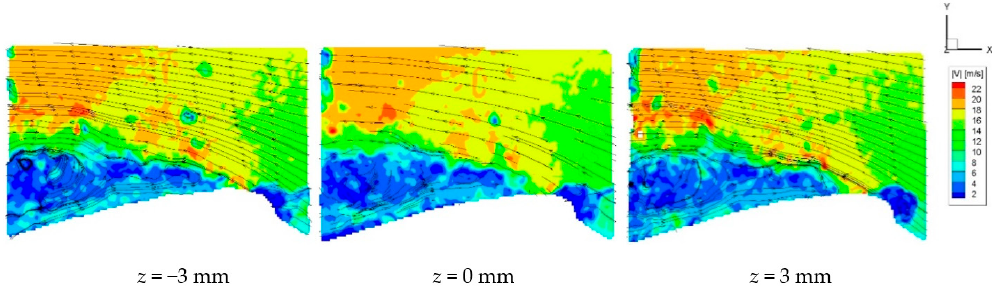
Figure 8. Three sample planes from two-camera 3D reconstruction for the dimpled airfoil at two AoA.